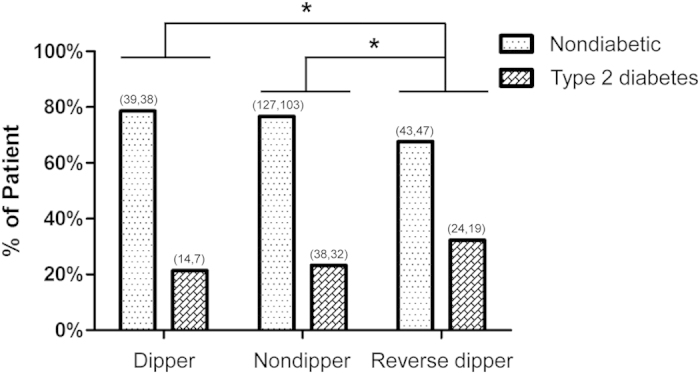
The distribution of diabetic and non-diabetic patients in each circadian BP pattern group.The difference between dipper and reverse-dipper pattern, nondipper and reverse-dipper pattern are statistically significant (P = 0.046 and P = 0.033, respectively). Patients with reverse-dipper pattern showed the lowest prevalence of non-diabetic and the highest prevalence of type 2 diabetes. (X, Y) above column indicate that (The number of Males, The number of Females). *indicates statistic significance between two group.